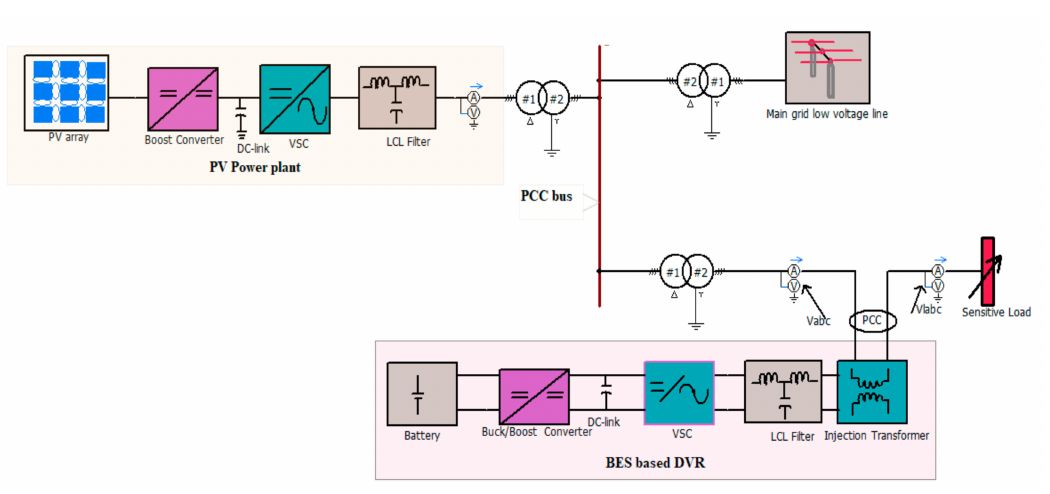
Figure 2. Grid-integrated PV power system with BES-based DVR.